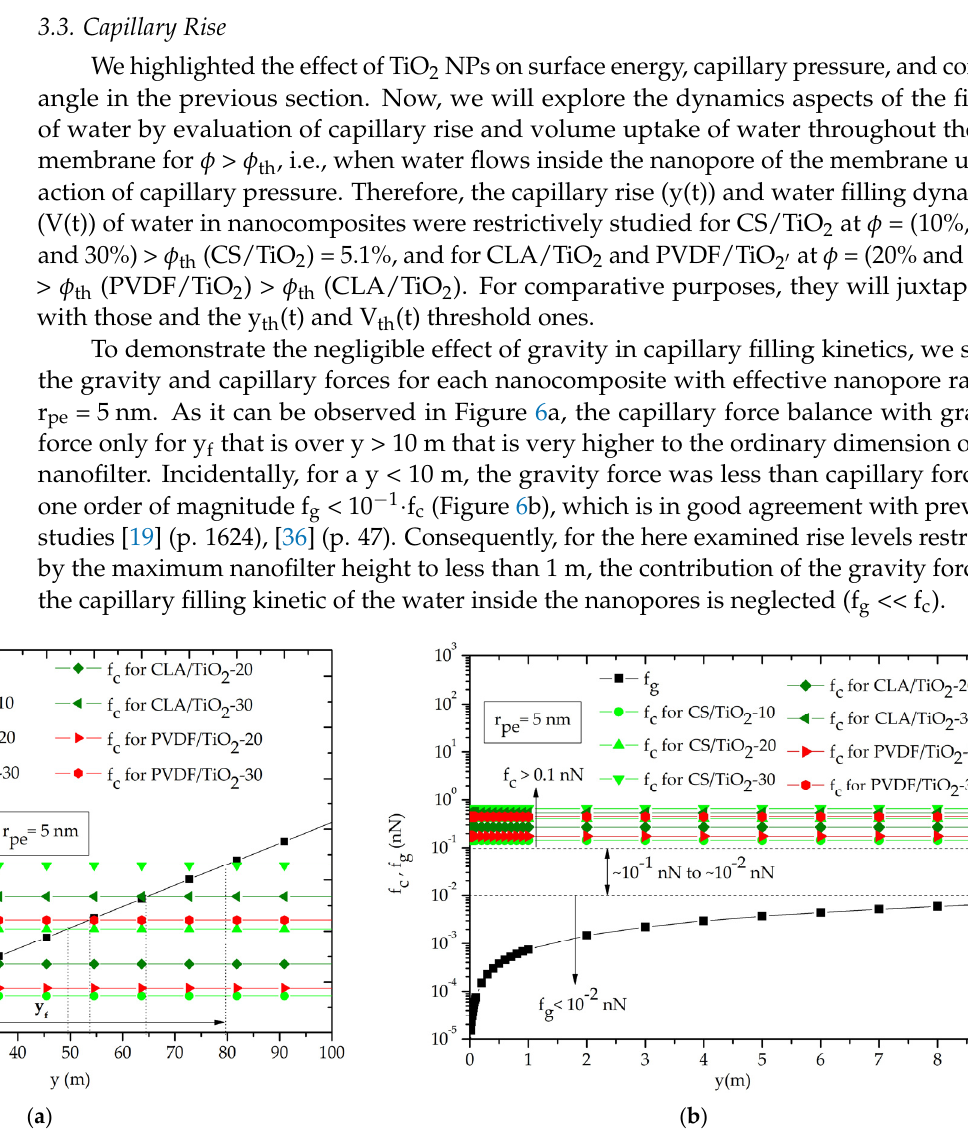
Figure 6. Gravity and capillary forces as function of distance rise in one nanopore: ( a ) the gravity force balance capillary force for at y f , ( b ) the strength of gravity force is negligible compared to the capillary force for distance (1 nm to 9 m).